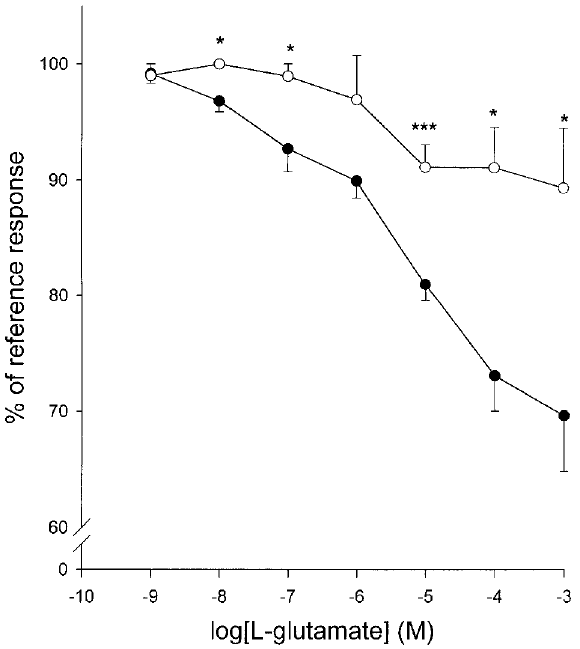
FIG. 1. L -Glutamate effect on epithelium-intact ( d ) and epithelium-denuded preparations ( s ). The responses are mean ±SE ( n = 5) and are plotted as a percentage of the reference response before the exposure to L -glutamate. * p < 0.05, *** p < 0.001, paired t -test.